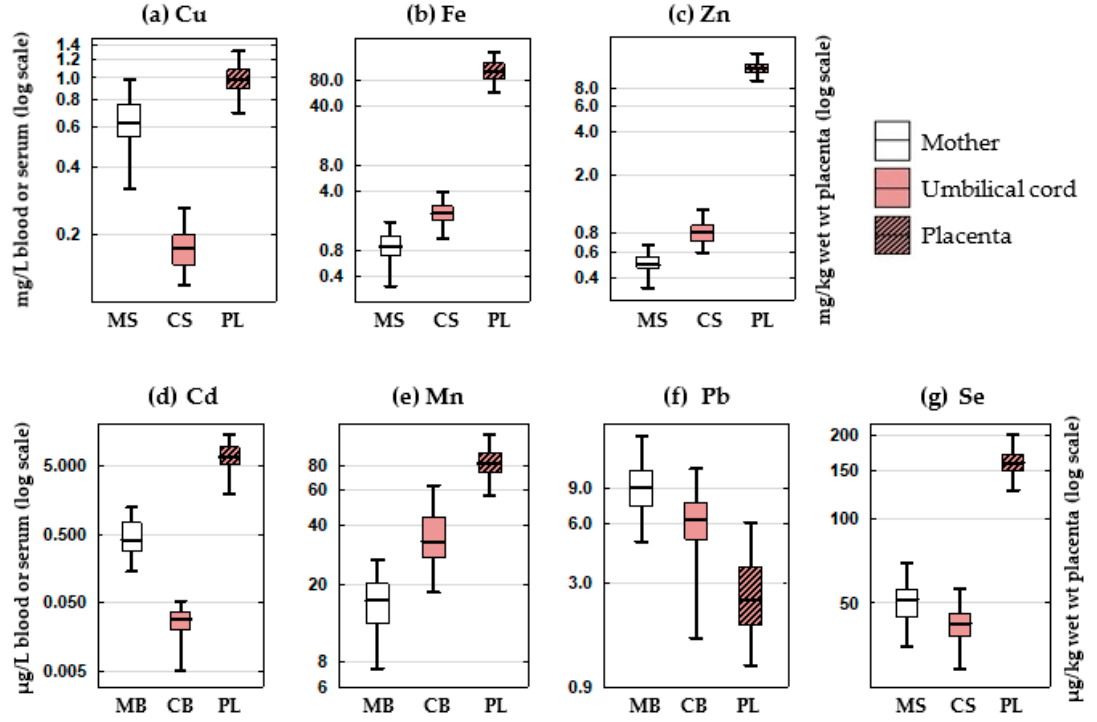
Figure 1. Concentration of ( a ) Cu, ( b ) Fe, ( c ) Zn, ( d ) Cd, ( e ) Mn, ( f ) Pb and ( g ) Se in the samples of maternal and umbilical cord blood and serum and placenta of 74 mother-newborn pairs. The boxes and lines represent 25%–75% interquartile range and median, respectively, and whiskers represent non-outlier range. Abbreviations: MB — maternal blood, MS — maternal serum, CB — cord blood, CS — cord serum, PL — placenta.